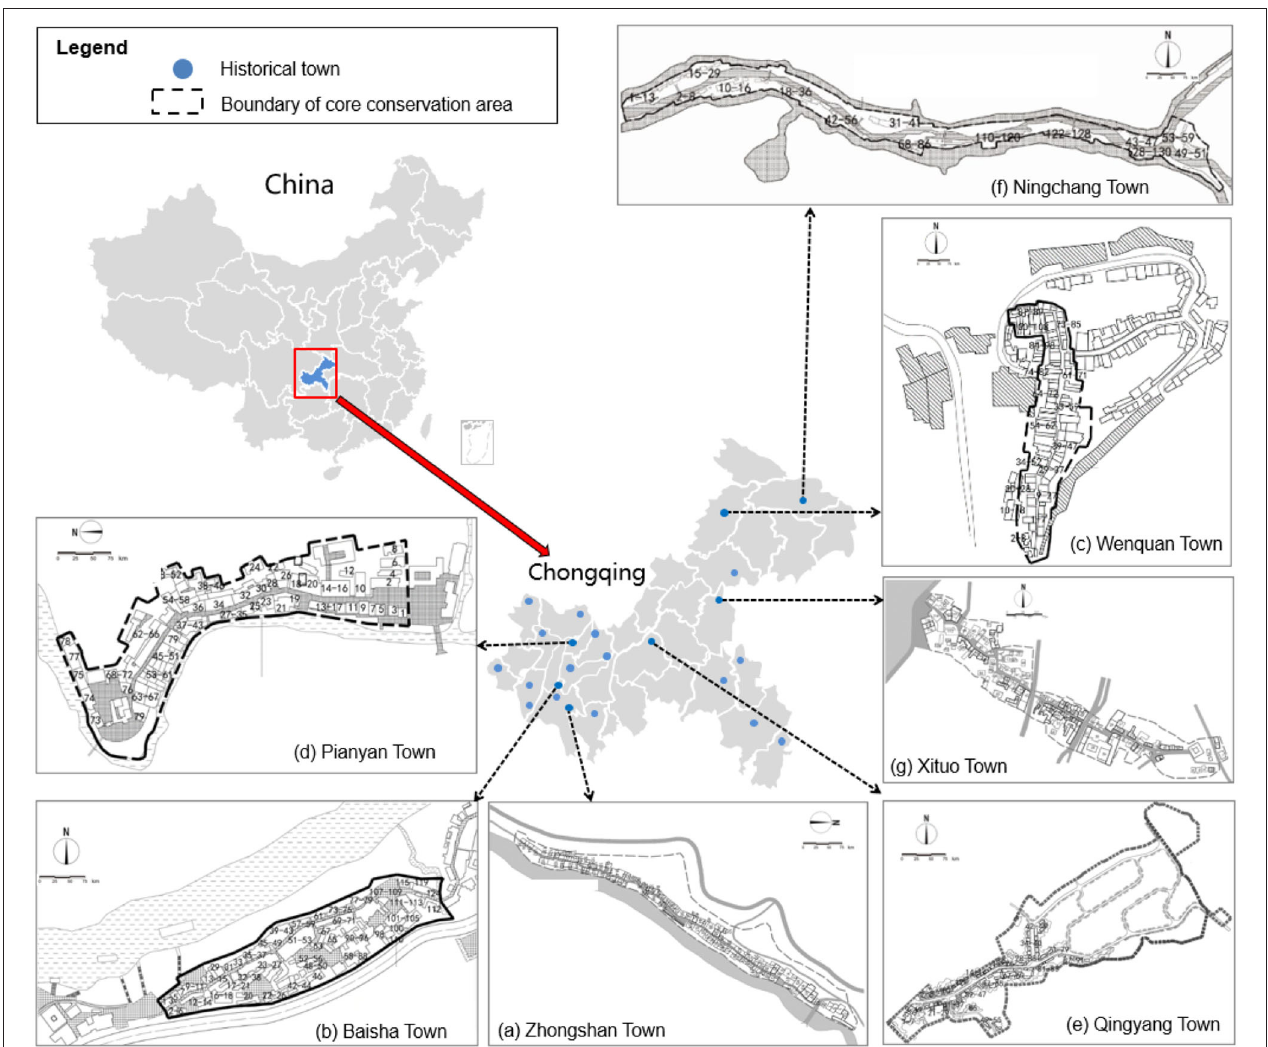
FIGURE 2 | Distribution of 23 national historical towns in Chongqing, China; and layout of the seven studied samples: (a) Zhongshan, ZS; (b) Baisha, BS; (c) Wenquan, WQ; (d) Pianyan, PY; (e) Qingyang, QY; (f) Ningchang, NC; (g) Xituo,